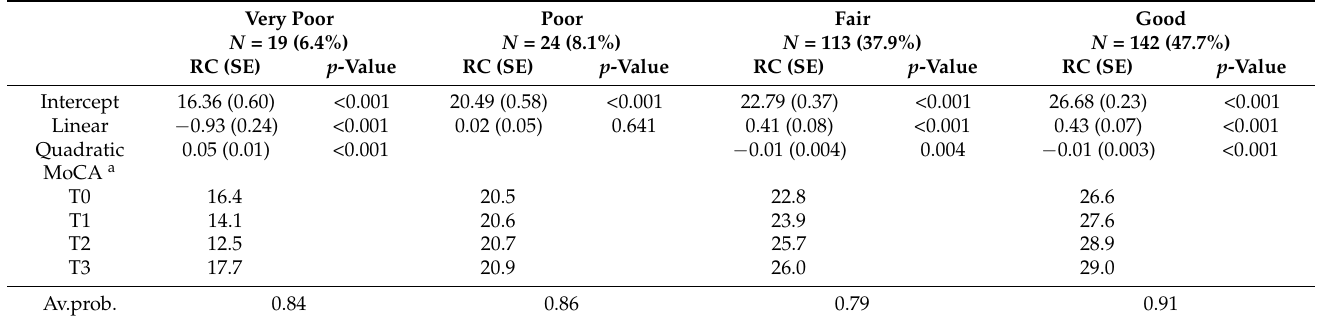
Figure 3. Groups with distinct MoCA score trajectories during the course of radiotherapy. Table 5. Results of growth mixture model for MoCA scores, n =